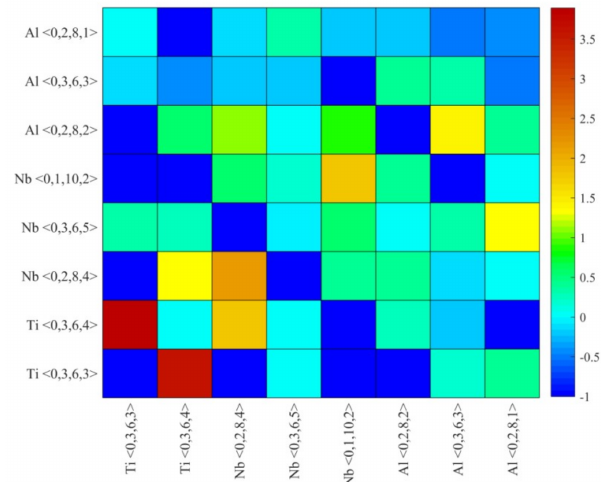
Figure 8. The distribution of connection factor F mn among eight typical Voronoi clusters in Ti 15 Nb 45 Al 40 glassy